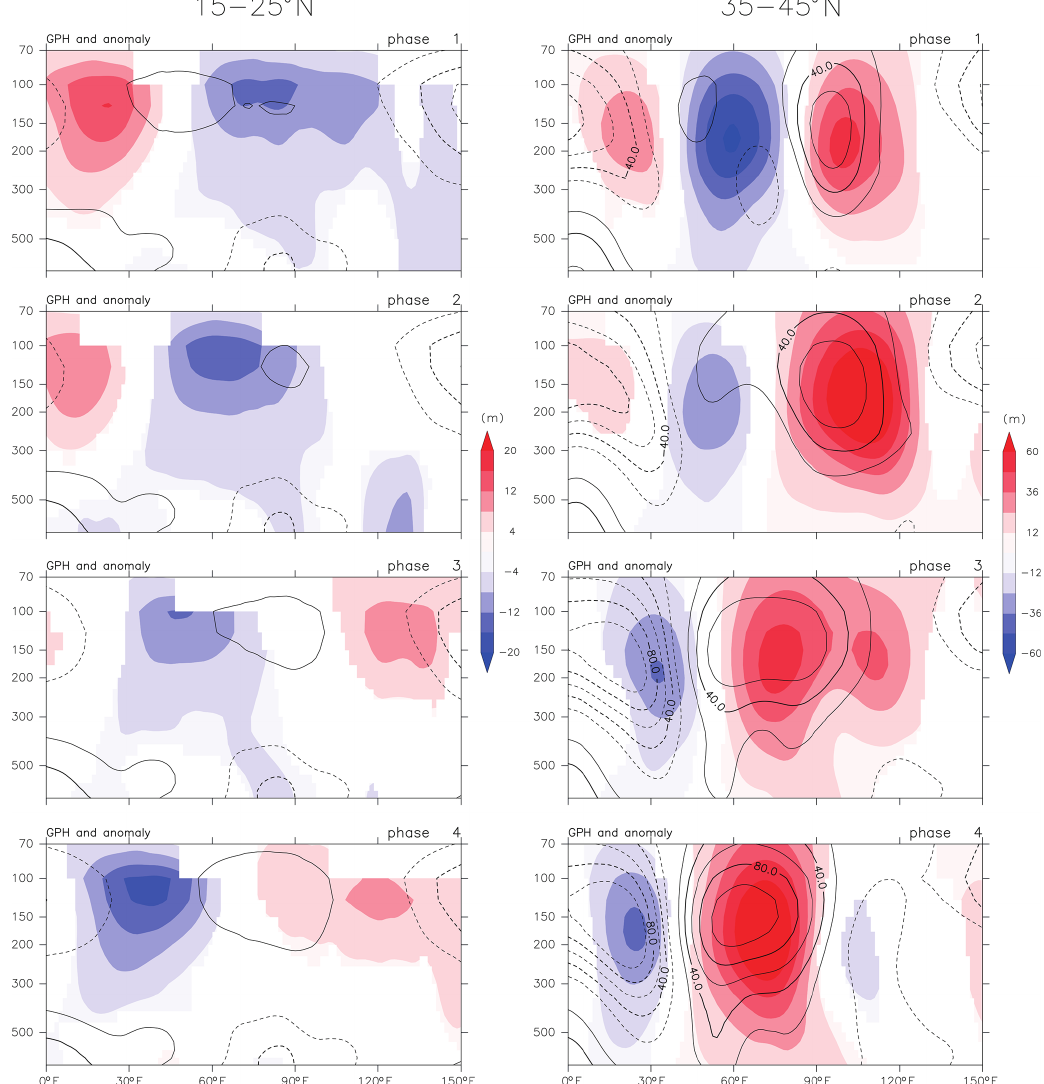
Figure 15. Composite of geopotential height in the longitude–pressure section. Contours show deviation from the zonal mean of the longitude sector, and its anomalies from climatology are shaded. The left and right columns respectively show maps averaged over 15–25 and 35–45 ◦ N. Only the first four of eight phases are shown. The contour interval is 20m. Only the areas with 95% significance, determined by standard t test, of geopotential anomalies are shaded. Note that different color scales are used for the left and right